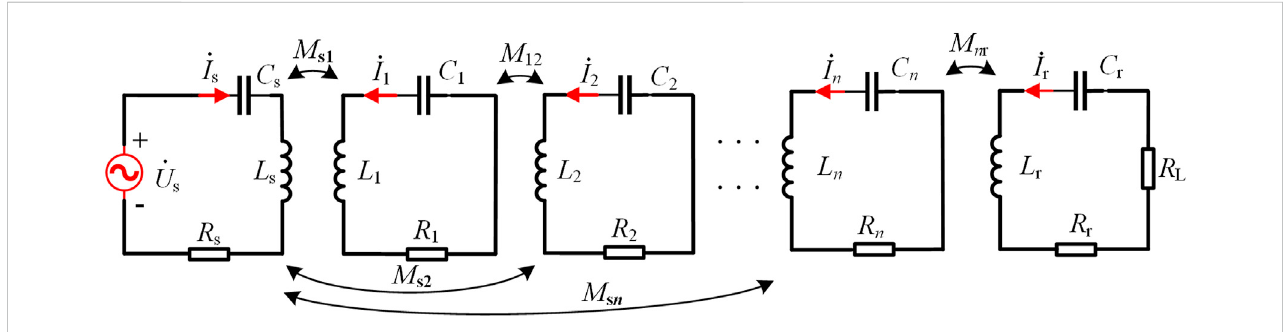
FIGURE 3 Equivalent circuit of multi-relay coil WPT